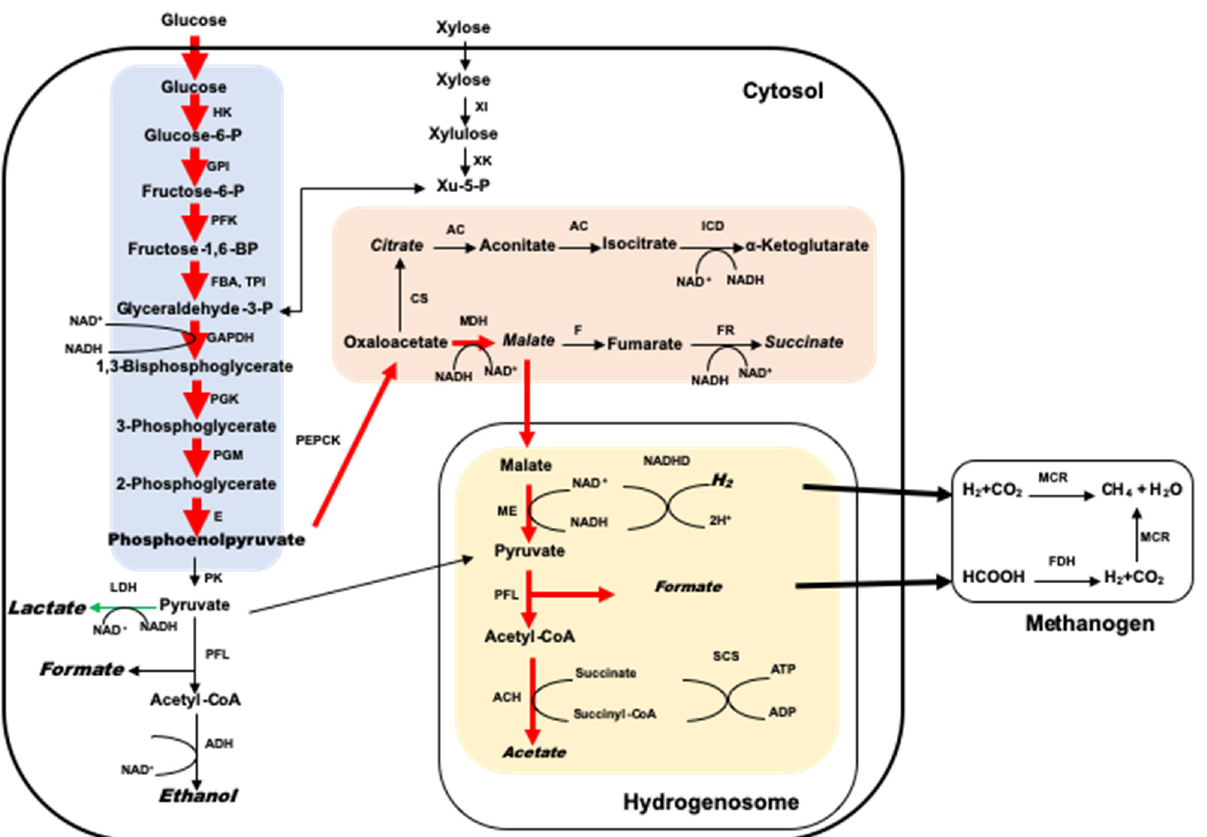
Figure 3. Proposed metabolic pathway for glucose by anaerobic fungi co-cultured with methanogens. The red and green arrows indicate stimulated and inhibited pathways. The proposed metabolites are indicated in italics. AC, aconitase; ACH, acetyl-CoA hydrolase; ADH, alkoholdehydrogenase; CS, citrate synthase; E, enolase; F, fumarase; FBA, fructosebisphosphate aldolase; FDH, formate dehydrogenase; FR, fumarate reductase; GAPDH, glyceraldehyde-3-phosphate dehydrogenase; GPI, glucose-6-phosphate isomerase; HK, hexokinase; ICD, isocitrate dehydrogenase; LDH, lactatedehydrogenase; MCR, methyl coenzyme-M reductase; MDH, malate dehydrogenase; ME, malic enzyme; NADHD, NADH dehydrogenase; SCS, succinyl-CoA synthetase; TPI, triosephosphate isomerase; XK, xylulokinase; XI, xylose isomerase; PFK, phosphofructokinase; PFL, pyruvate formate lyase; PGK, 3-phosphoglycerate kinase; PGM, phosphoglucomutase; PK, pyruvate kinase; PEPCK, phosphoenolpyruvate carboxykinase.